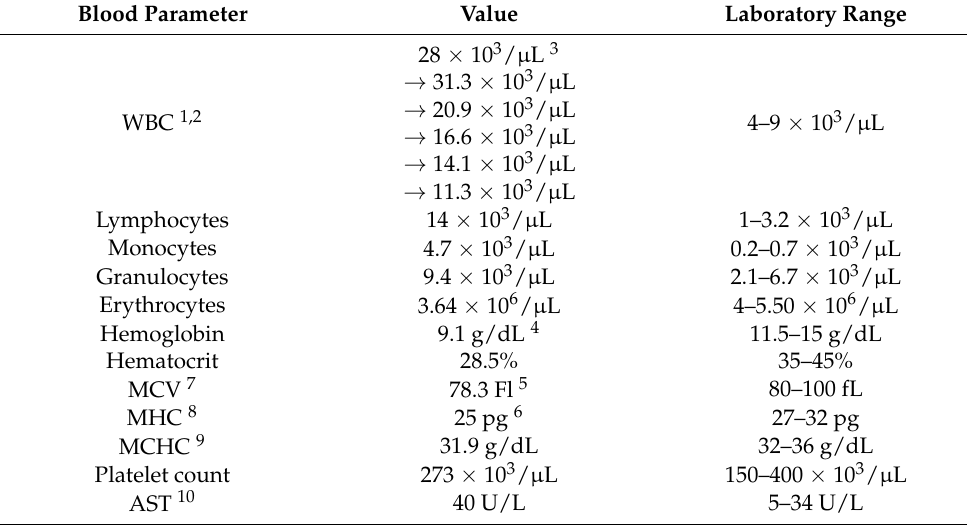
Table 1. Blood analysis determined at admission. Blood